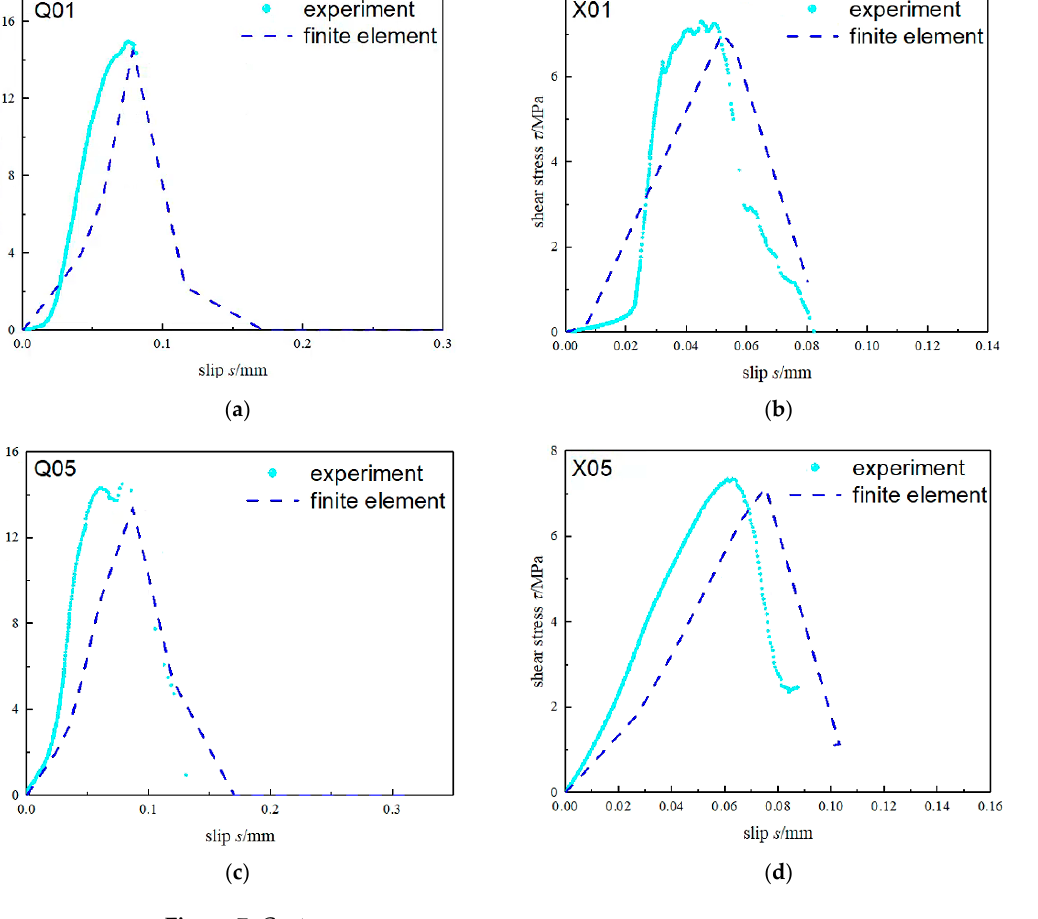
( f ) Figure 7. Comparison of Bond–Slip Curve between Different Groups. ( a ) Q-01; ( b ) X-01; ( c ) Q-05; ( d ) X-05; ( e ) Q-08; ( f ) X-08. 6. Verification Test In order to further verify the validity of Equations (2) and (3) given in Section 3, a verification test was carried out in this paper. In this verification test, six specimens of CFRP-strengthened steel plate using Q345B and X100 (each for three) with a bonding in- terface thickness of 1.0 mm were used. All test conditions were exactly the same as those